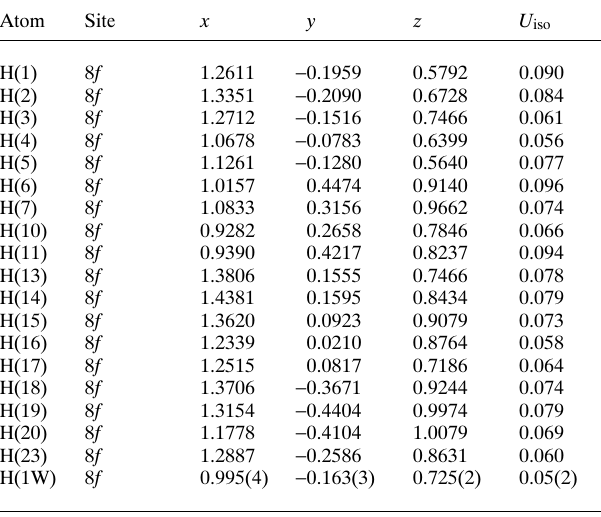
Table 2. Atomic coordinates and displacement parameters (in Å 2 )